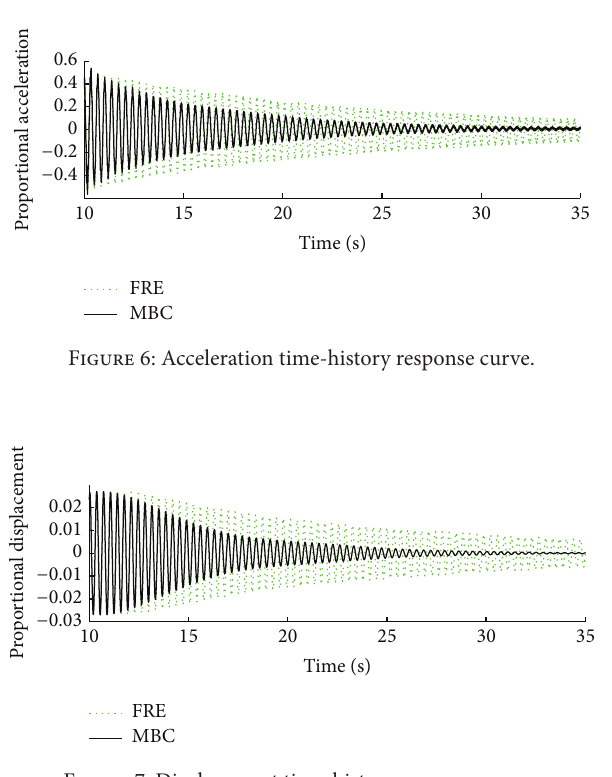
Figure 7: Displacement time-history response curve.